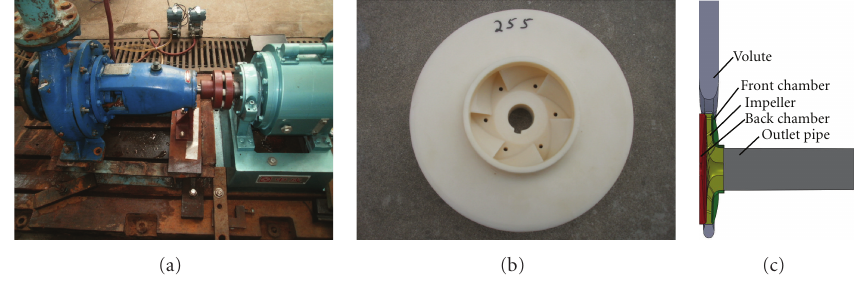
Figure 2: (a) Test PAT. (b) Impeller. (c) 3D model .